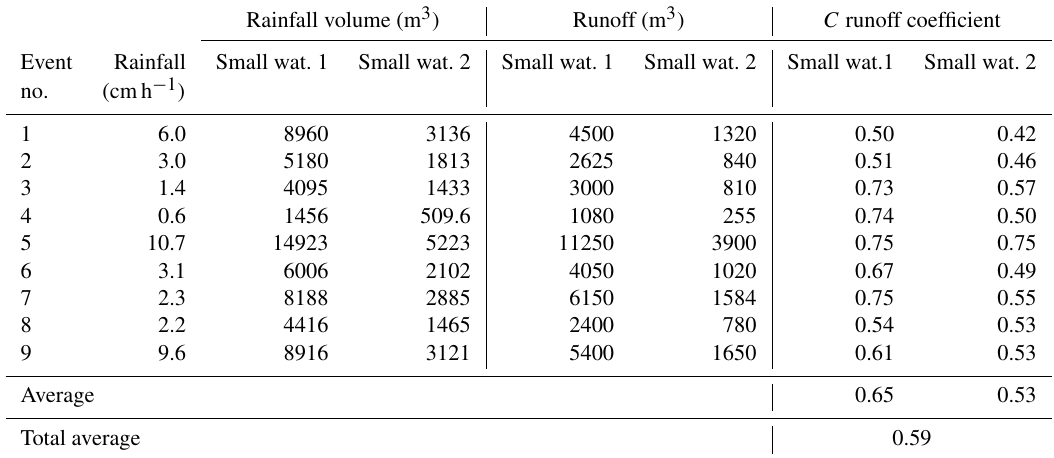
Table 5. Observed C values obtained from field experiments in two small watersheds that were dominated by plantation cover.